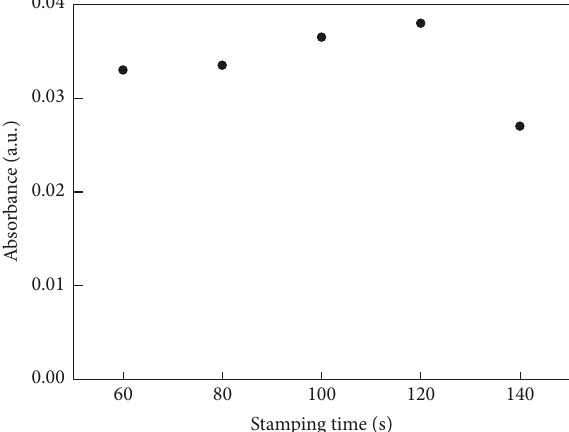
Figure 6: Peak absorbance at 390 nm of TPBi film as a function of stamping